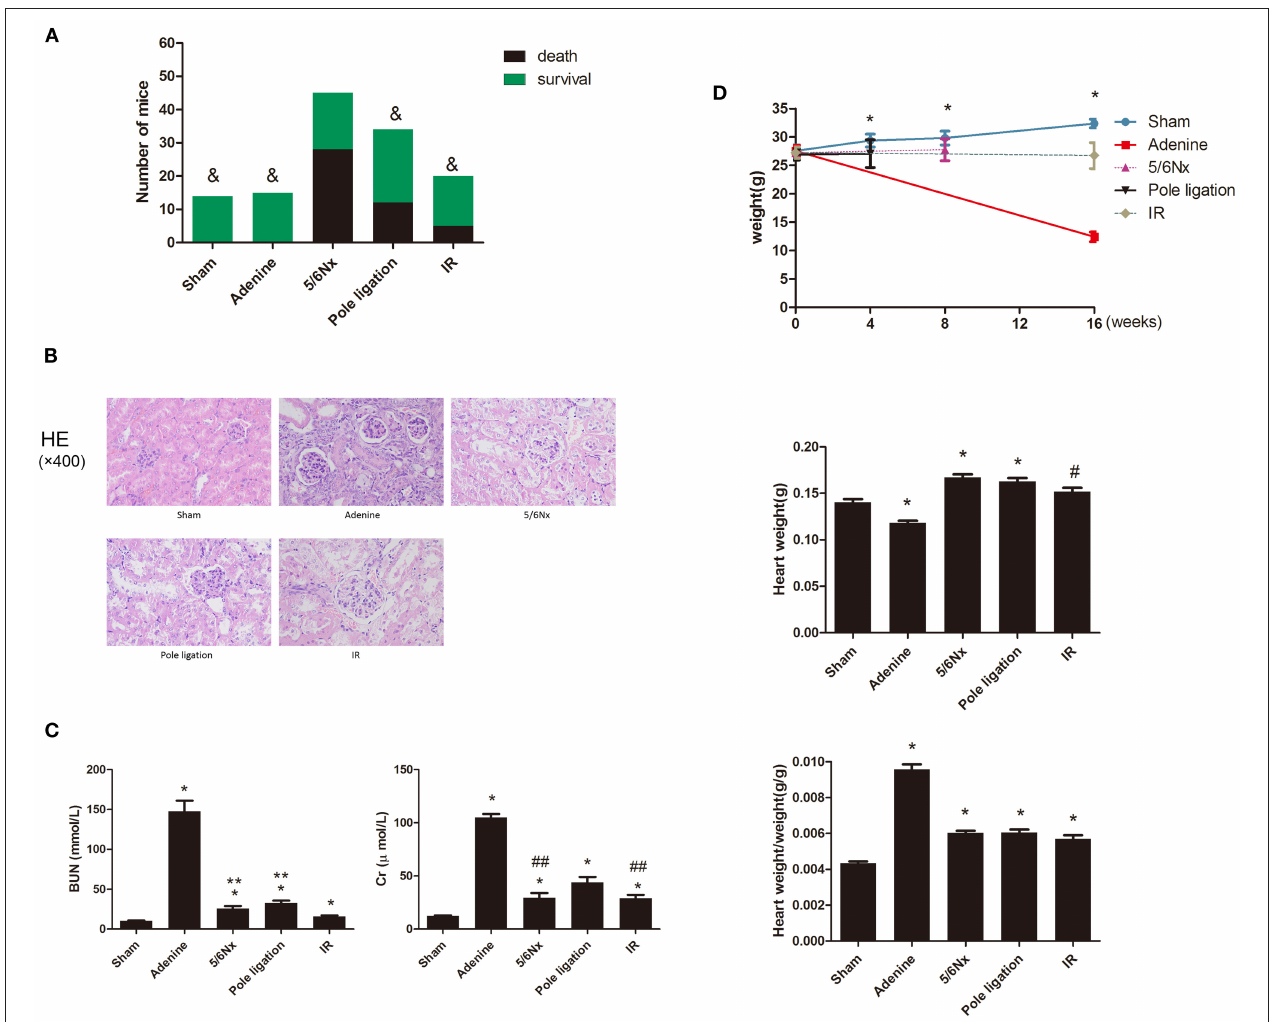
FIGURE 2 | (A–C) Between-group comparisons of survival rate, kidney pathology, and renal function. (A) Comparisons of survival rates in the sham group, adenine group, 5/6 nephrectomy group (5/6Nx), pole ligation group, and uninephrectomy plus contralateral ischemia followed by reperfusion group (IR). (B) Comparisons of renal pathology in different models. (C) The mean BUN and Cr in the sham group and modeling groups. Data are presented as the mean ± SEM ( n = 14–22). & P < 0.05, vs. 5/6Nx group; * P < 0.01, vs. Sham; ** P < 0.01, vs. IR group; # P < 0.05, vs. Sham; ## P < 0.05, vs. pole ligation group. (D) Between-group comparisons of body weight, heart weight, and heart weight-to-body weight ratio. (D) The mean body weight, heart weight, and heart weight-to-body weight ratio in the sham, adenine group, 5/6 nephrectomy group (5/6Nx), pole ligation group, and uninephrectomy plus contralateral ischemia followed by reperfusion group (IR). Data are presented as the mean ± SEM ( n = 14–22). * P < 0.01, vs. Sham; # P < 0.05, vs.